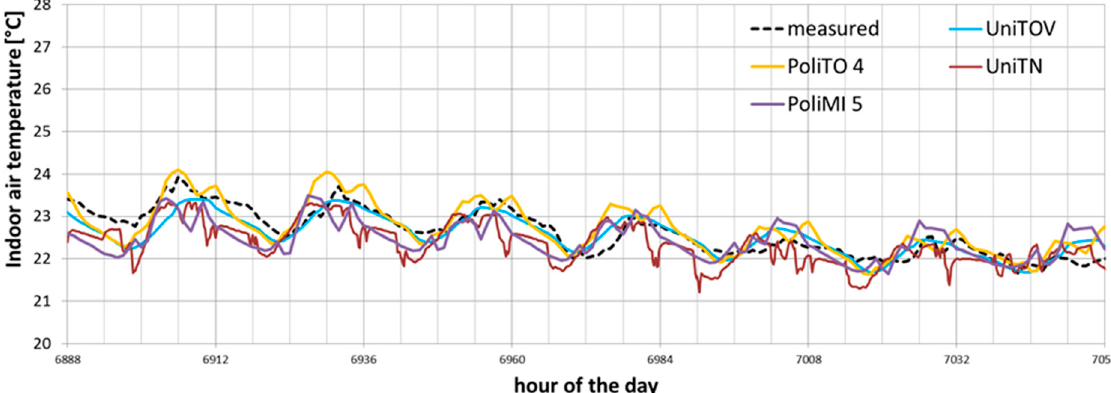
Figure 6. Simulated (calibrated models) and measured indoor air temperature (3rd week of October).